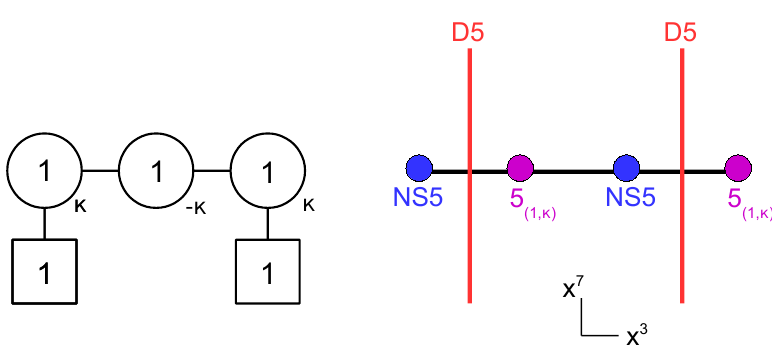
Figure 18 . Quiver and brane realization of the T [3] theory in the x 7 ; 3